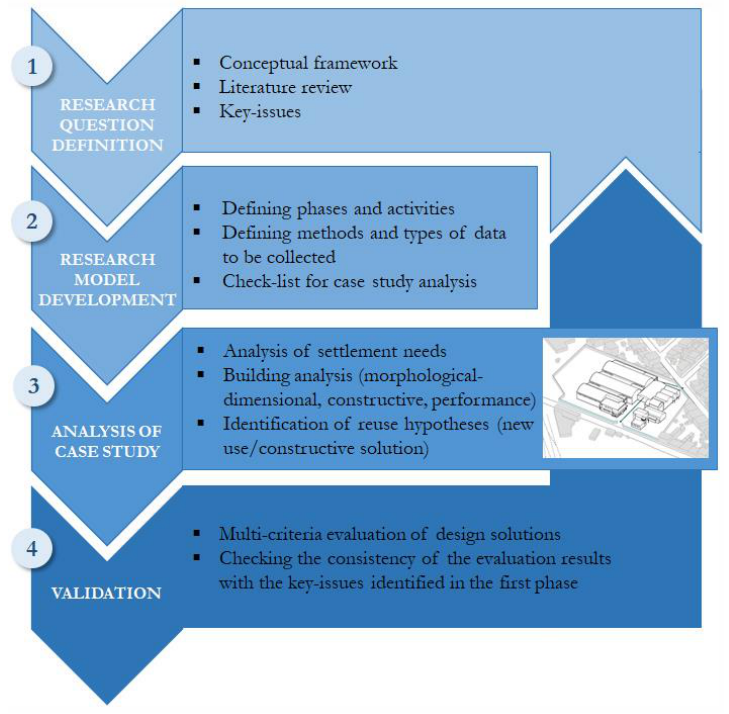
Figure 1. The research